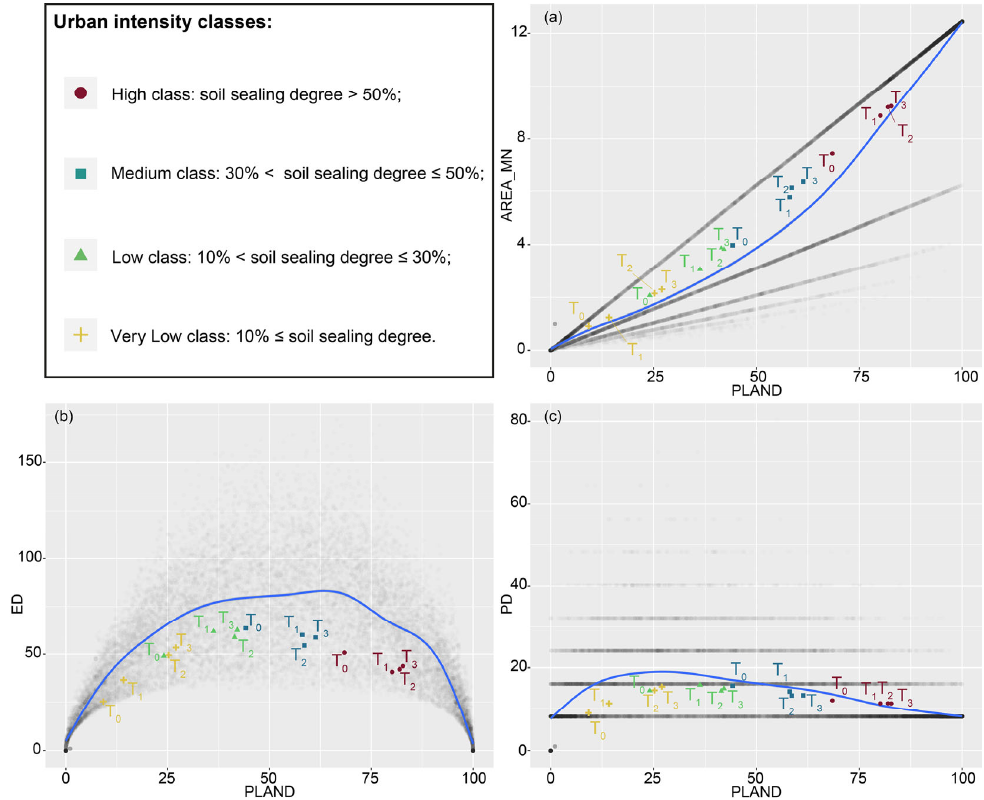
Figure 7. Trajectory analysis for the different urban intensity classes defined at T 0 . Cartesian relationship spaces report measured configuration metrics (grey dots) in relation to urban cover, along with the relative fitted curves (blue line) and the mean metric values (colored dots) for each time step (T 0 , T 1 , T 2 , T 3 ). PLAND: percent of urban area vs. ( a ) AREA_MN: Mean patch area, ( b ) ED: Edge density, and ( c ) PD: patch density.